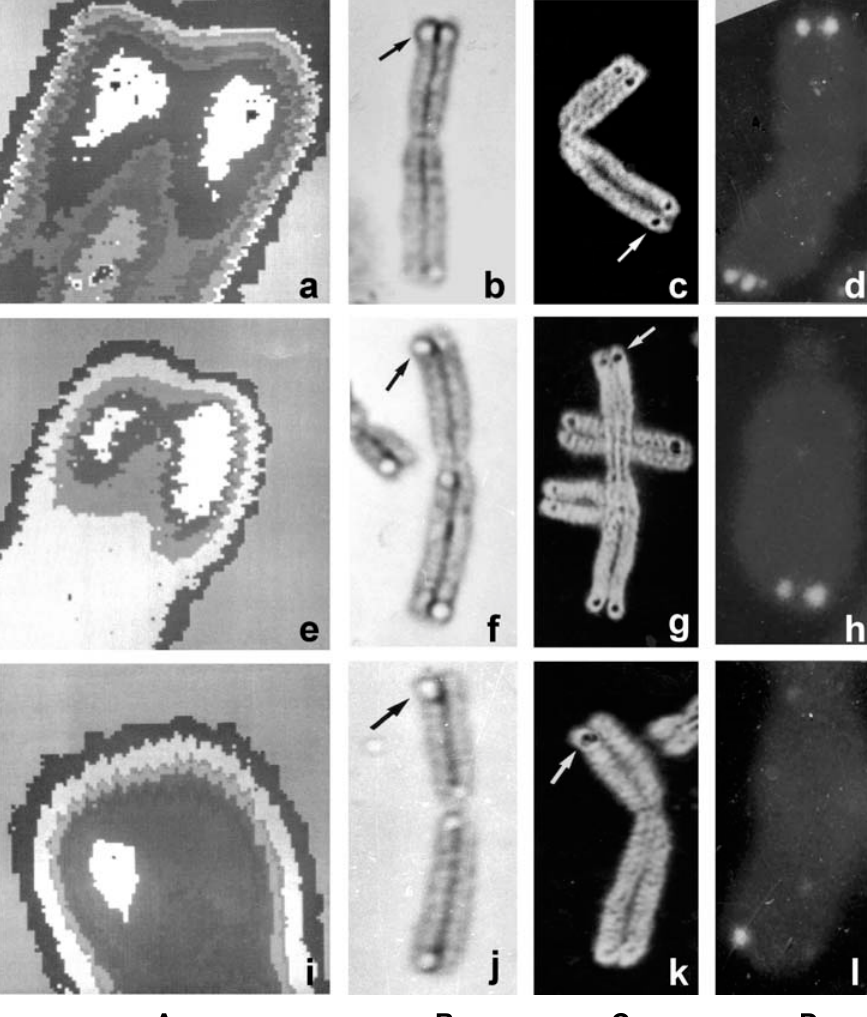
Figure 1 - Comparison of size and localiza- tion of high densities, induced holes and telomeric probes in normal CHO and hu- man chromosomes as observed with differ- ent methods. Column A , Graphic images of subtelomeric high densities obtained by mi- crophotometric scanning of T-banded CHO chromosomes; columns B and C , holes as observed with phase and reflection micros- copy, respectively; column D , human chro- mosomes labeled with a telomeric fluores- cent probe. Upper row : High densities ( den- sity pattern type 1 ; a) as well as holes and fluorescent signals are of similar size in both chromatids. Middle row : Higher density ( type 2 ; e) and a larger hole (f, g) and fluo- rescent signal (h) are seen predominating in one chromatid. Lower row : (i) Sub- telomeric high density is concentrated in one chromatid ( type 3 ; i); holes in only one chromatid (j and k), and one fluorescent sig- nal (l) are